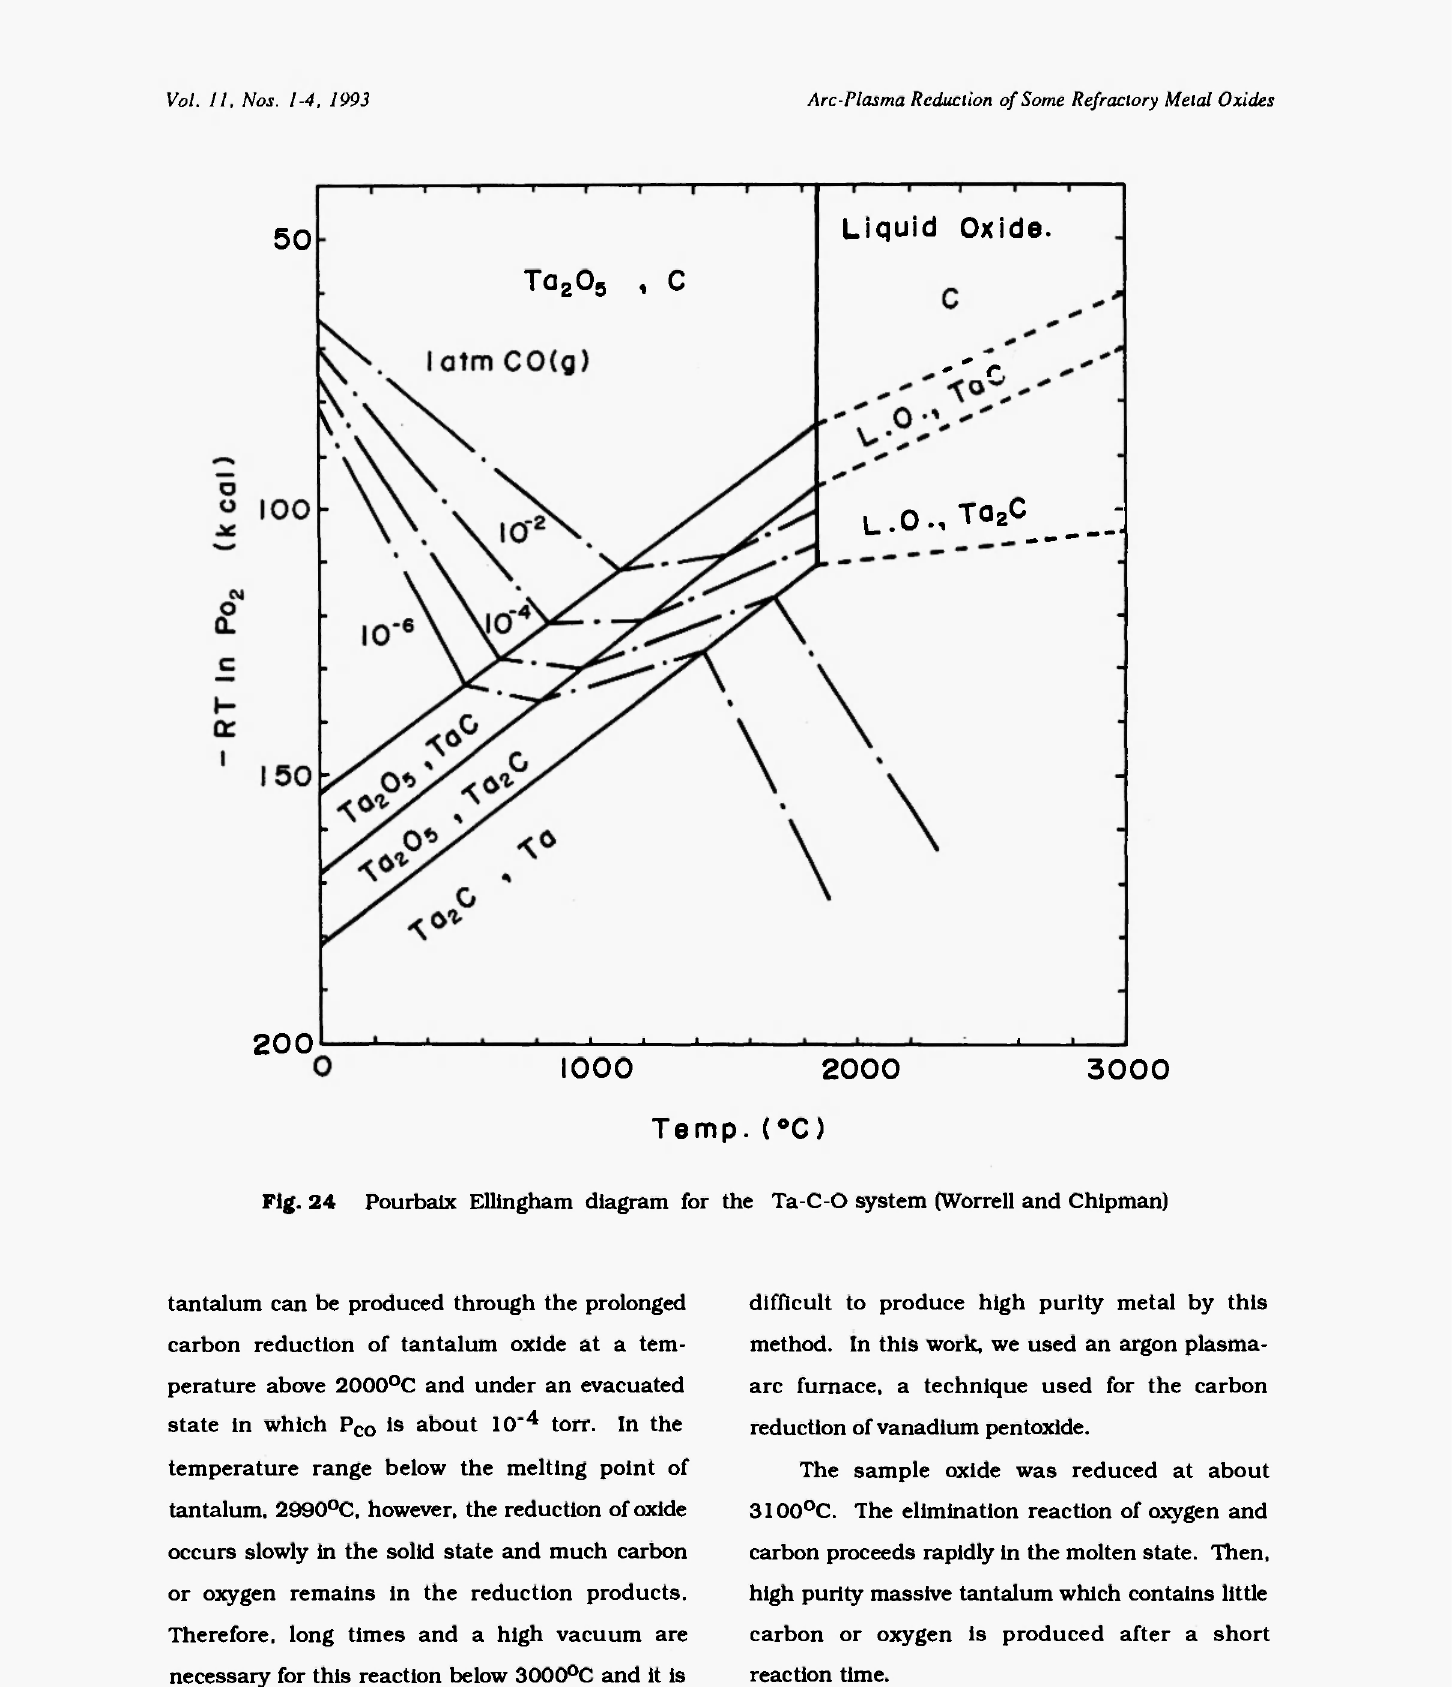
Pourbalx Ellingham diagram for the Ta-C-O system (Worrell and